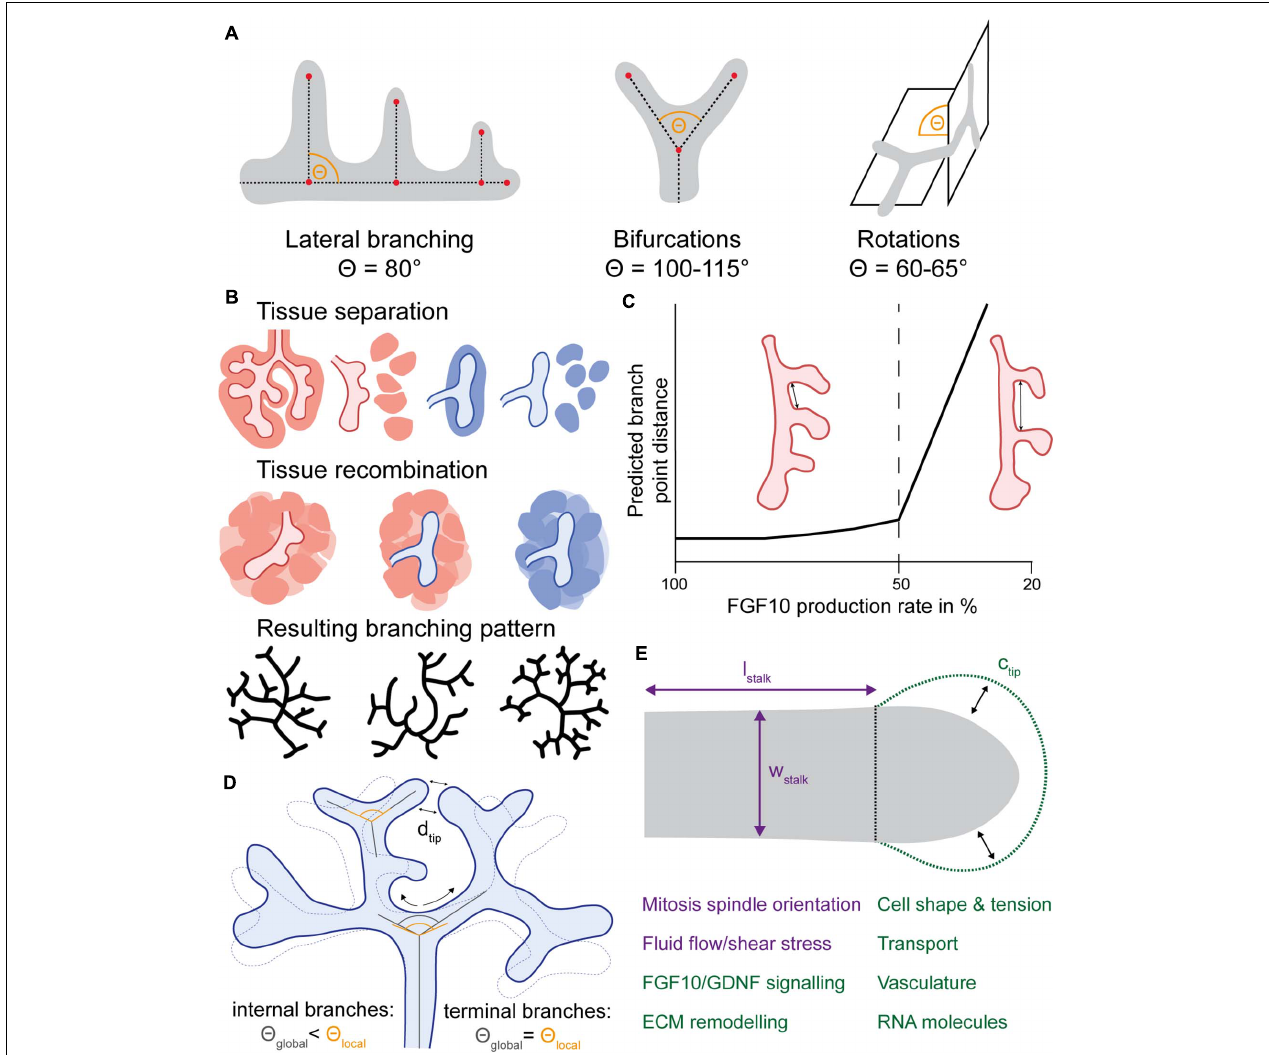
FIGURE 2 | Regulation principles of branching hallmarks in lung and kidney morphogenesis. (A) Branching modes used by lungs and kidneys. Lateral branches in the lung are oriented at an angle of around 80 ◦ . In both organs, bifurcations occur at a divergence angle of around 100–115 ◦ , while rotations of bifurcation events show a dihedral angle of around 60–65 ◦ . (B) Mesenchyme as pattern modulator. Separation of mesenchymal and epithelial tissue and subsequent re-arrangement of the mesenchyme around the epithelium destroys any potential mesenchymal pre-patterning. In homotypic recombination experiments, the respective organ-specific branching pattern is maintained, while in heterotypic recombination experiments lung mesenchyme “reprograms” the ureteric bud to adapt a lung-like branching pattern. (C) Regulation of branch point distance in the lung. Fgf10 hypomorphic lungs with a reduction of FGF10 expression by 55% exhibit a wider spacing of the first three lateral branches of the left lung lobe (right lung scheme), while other allelic combinations with a milder reduction in Fgf10 expression do not differ from wild type lungs (left lung scheme). The lung schemes were reproduced from Ramasamy et al. (2007). Accordingly, the ligand-receptor-based Turing mechanism predicts that the spacing of branch tips depends on the rate of ligand expression and is only affected if this rate falls below a certain threshold (dashed line). The graph was reproduced from Celliere et al. (2012). (D) Branch angle remodeling in the kidney. Local bifurcation angles (starting direction of daughter branches) are relatively constant, while global bifurcation angles (direction relative to terminal branch point) show spatial and temporal dynamics. Compressive remodeling of internal branches leads to an increased curvature of these internal branches. Concurrently, terminal branches move closer toward each other which reduces the inter-tip distance d tip , thereby promoting tip packaging. (E) Branch shape regulation. The shape of branch stalks and tips are regulated differently. The branches in lungs and kidneys show anisotropic growth, meaning that the increase in stalk length l stalk is larger than in stalk width w stalk , due to a biased mitosis spindle orientation. Fluid flow and resulting shear stress is able to explain biased elongation in lungs and kidneys. Branch tip shape is regulated by several factors, such as signaling interactions, ECM remodeling or cell tension dynamics, which are highly interconnected. Perturbation of these shape determinants primarily leads to dilated buds characterized by an increased tip circumference c tip and the absence of cleft